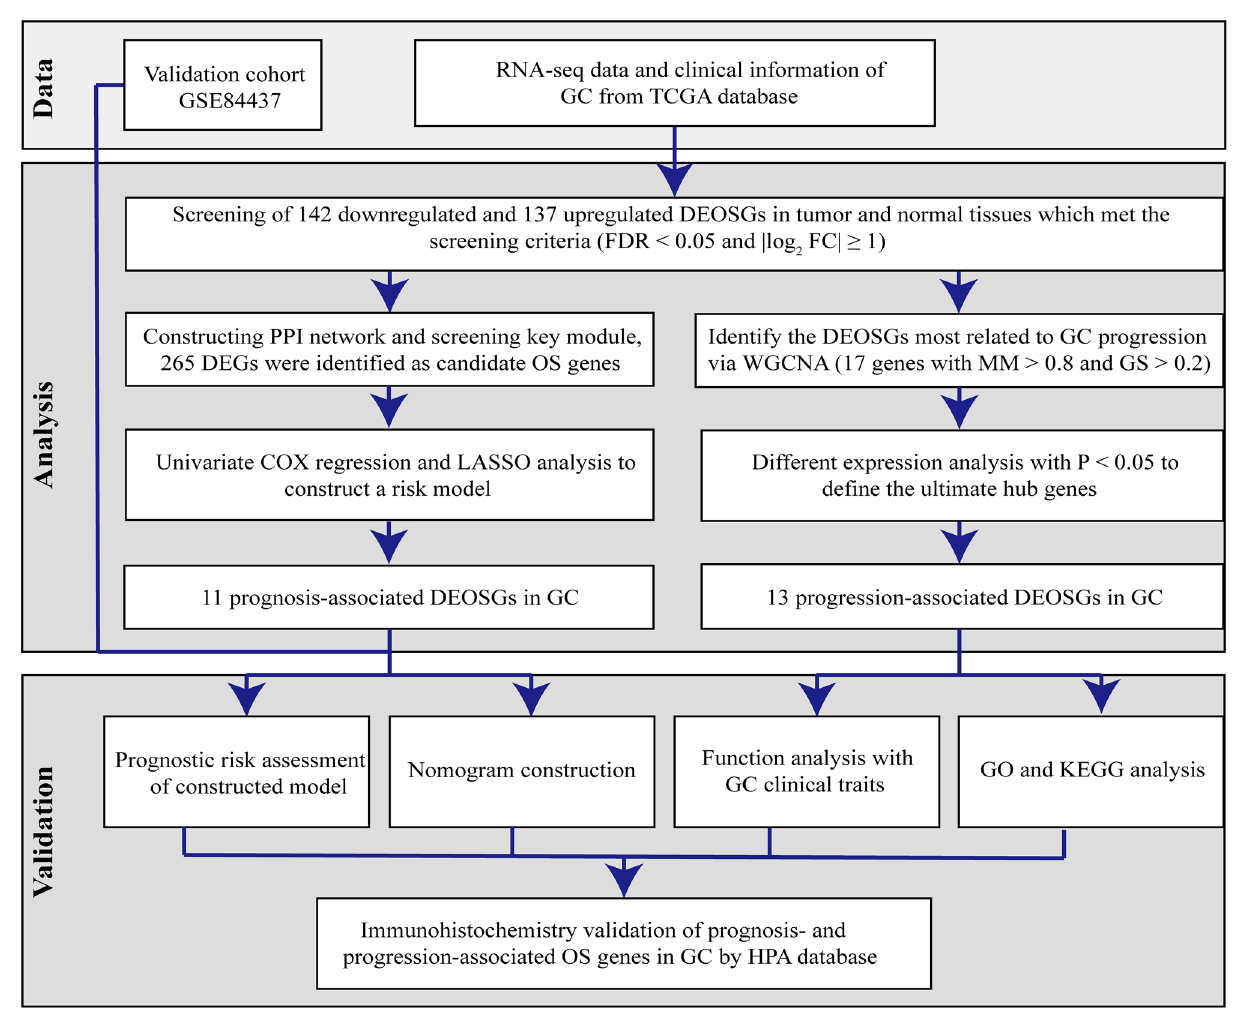
Figure 1. Flowchart describing the schematic overview of the study